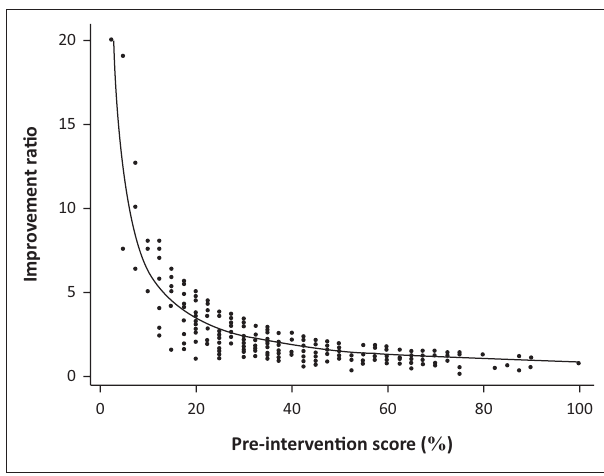
FIGURE 3: Improvement in scores is inversely proportional to the pre- intervention test score, with those who scored poorly initially improving by a proportionately greater degree than those with initially higher scores. The improvement ratio is calculated as the post-intervention score divided by the pre-intervention